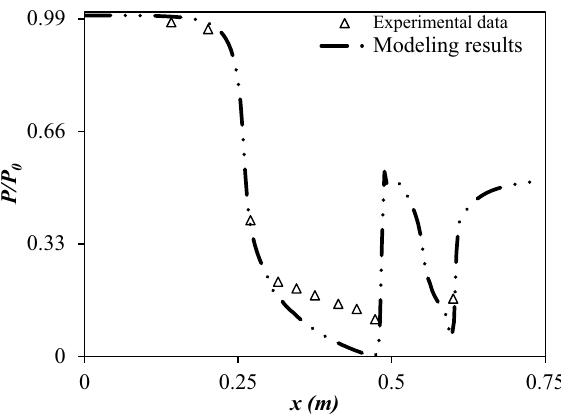
Figure 5. Validation of the developed CFD model by recorded experimental data by Eriqitai et al. 62